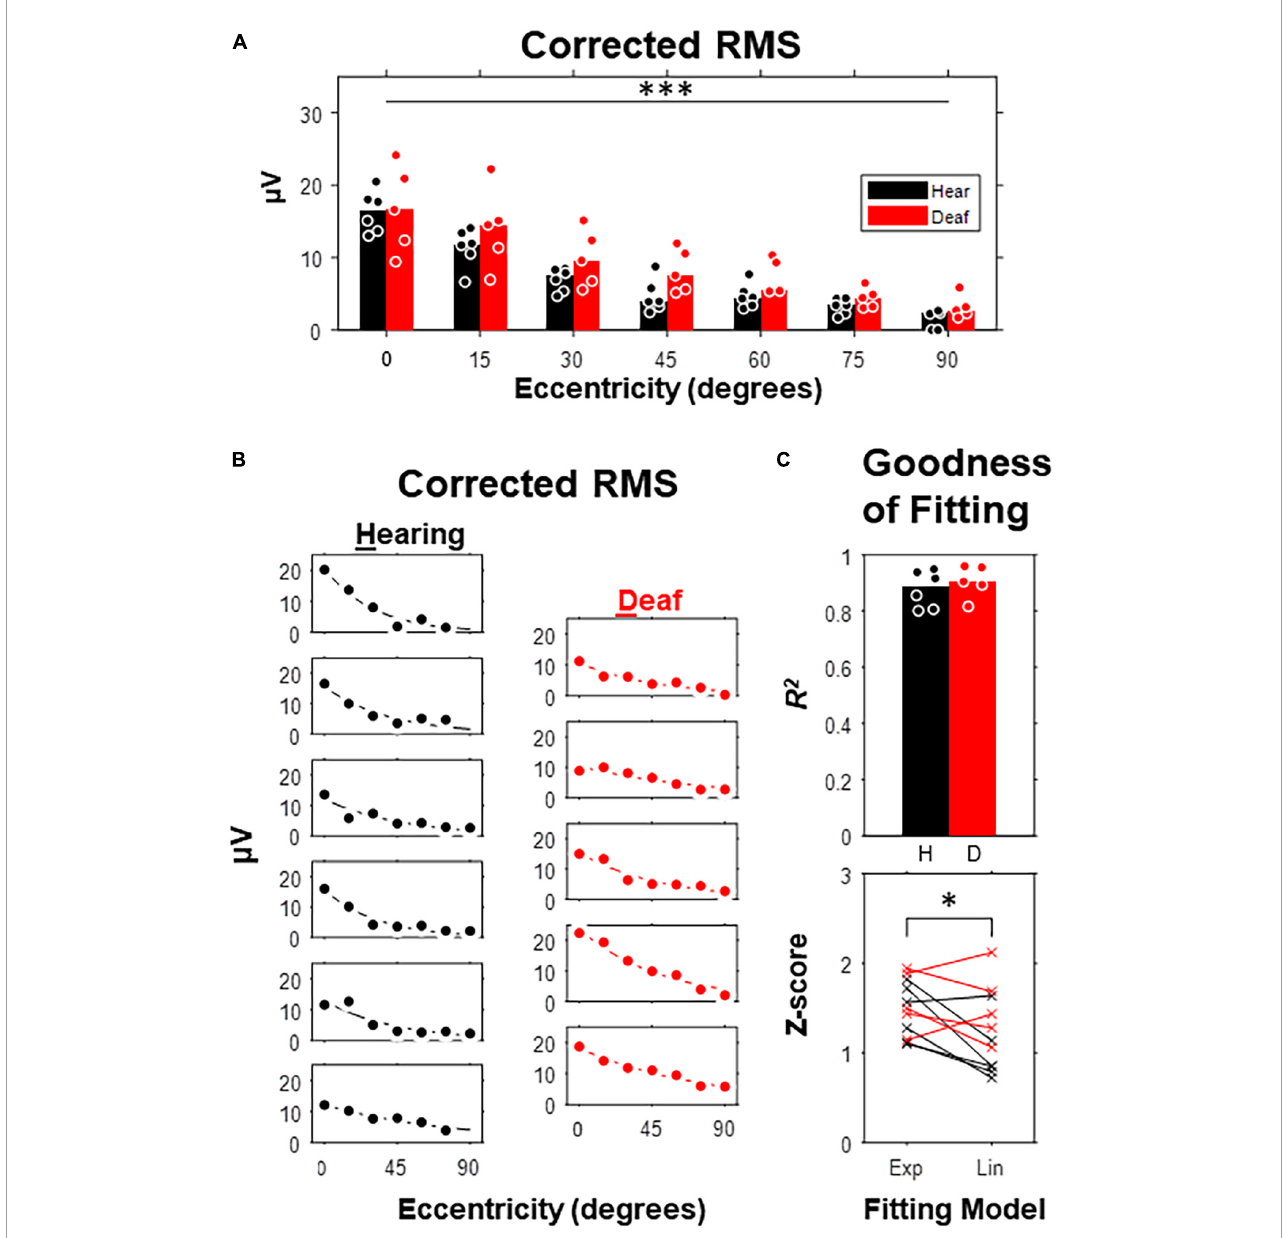
FIGURE3 Corrected Root-Mean-Square (RMS) as a function of stimulus eccentricity. (A) RMS over a 420-ms post-stimulus window corrected with an 80-ms pre-stimulus baseline. Dot, data for individual subject. Bar, median. (B) Curve fitting with an exponentially decay model carried out for each of 6 hearing and 5 deaf subjects. (C) Goodness of fit. Top, adjusted R 2 compared between hearing and deaf group. Bottom, Fisher’s Z scores of the adjusted R 2 derived from exponential and linear fitting for each subject. ∗ p < 0.05; ∗∗∗ p < 0.001 for the main effect of